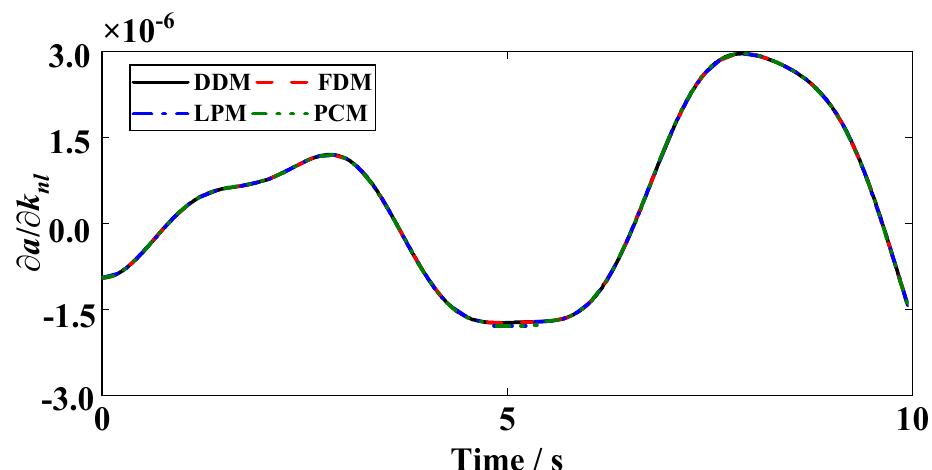
Figure 3. Acceleration sensitivity with respect to the nonlinear stiffness k nl ( 0 u = 1 cm and ∆ k nl = 10 −6 k nl ).